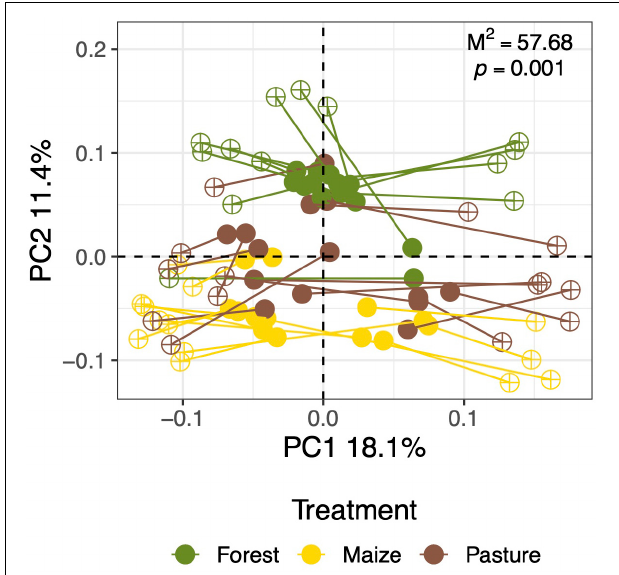
FIGURE 6 | Procrustes analysis of the principal coordinate analysis (PCoA) of Bray-Curtis similarity matrices of the fungal and bacterial communities of the same soil samples collected from a coniferous forest soil (Forest), deforested for grazing (Pasture) and a maize ( Zea mays L.) cultivated deforested soil (Maize) at the “ Área de Protección de Flora y Fauna Nevado de Toluca ” (Mexico).